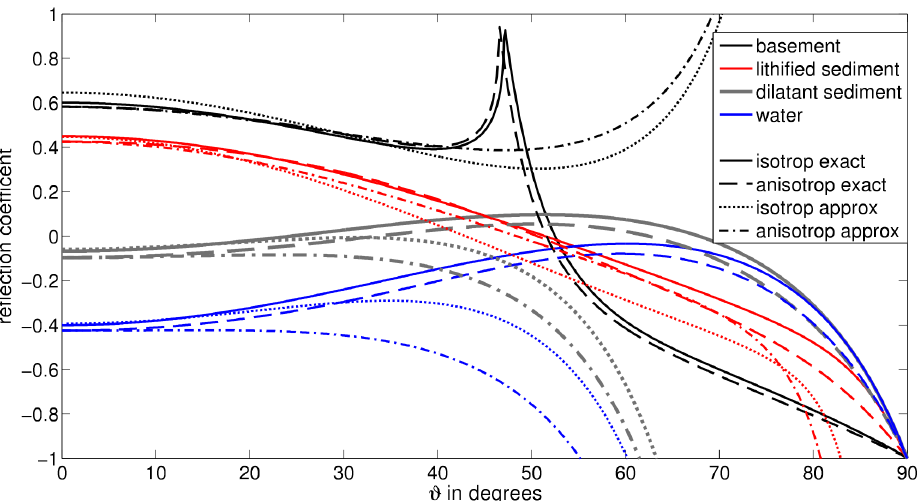
Figure 6. P-wave reflection coefficients for ice–bed interface with different bed properties as a function of phase angle of incidence ϑ : basement (black), lithified sediments (red), dilatant sediments (gray) and water (blue). The solid and dotted lines are the reflection coefficients for an isotropic ice overburden, the dashed and dashed-dotted lines for the anisotropic (VSM) overburden. The solid and dashed lines are the reflection coefficients calculated with exact equations for VTI media given by Graebner (1992) and Rüger (2002). The dotted and dashed- dotted lines are approximate calculations following the approach by Aki and Richards (2002) for the isotropic case and that of Rüger (1997) for the anisotropic case, respectively. Property values for the bed and isotropic ice are taken from Peters et al. (2008). For the anisotropic ice the elasticity tensor given by Gammon et al. (1983) is